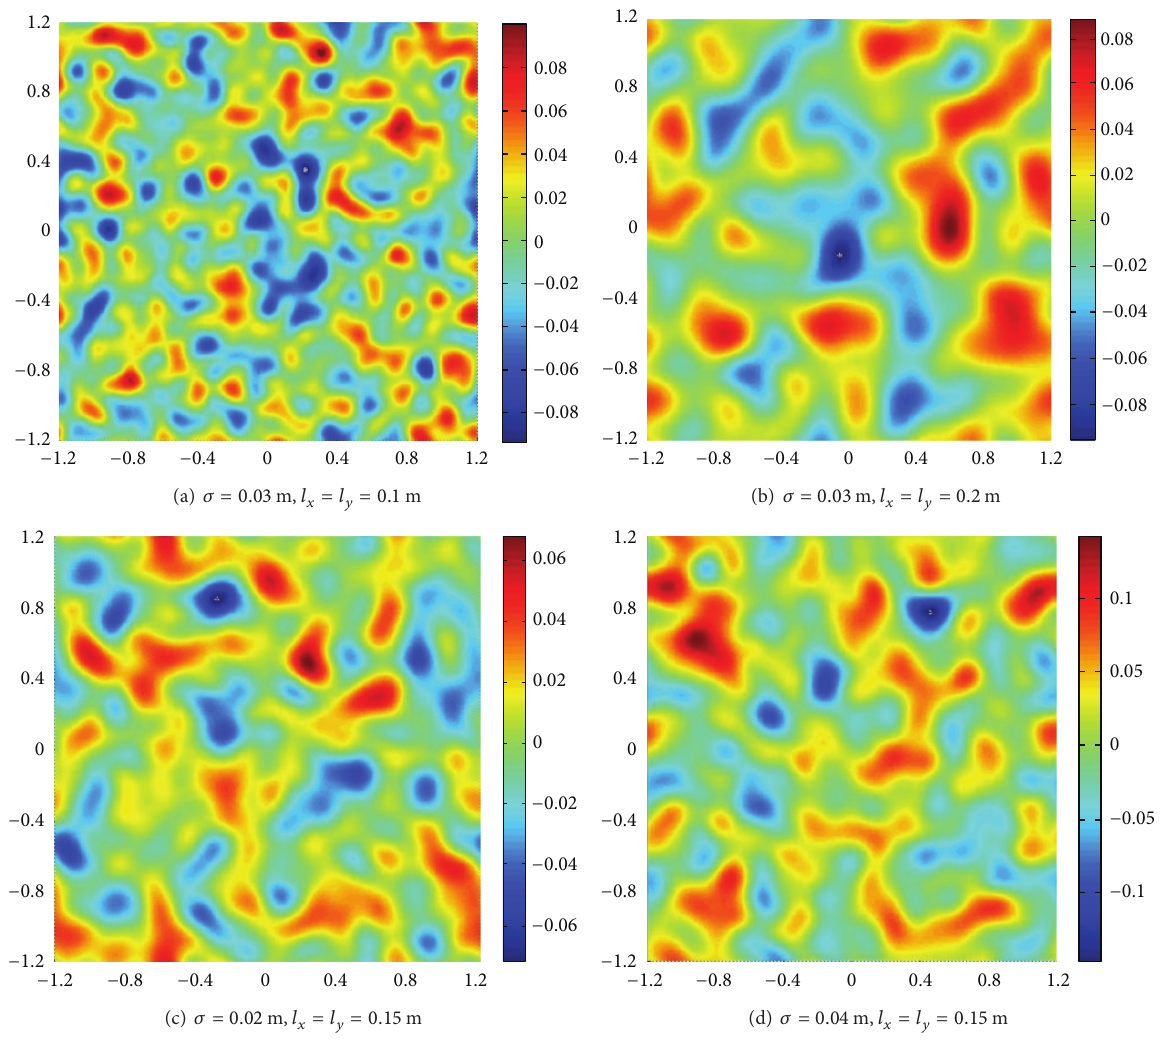
Figure 1: Simulation of 2D Gaussian randomly rough surface (the unit of bar is meter).